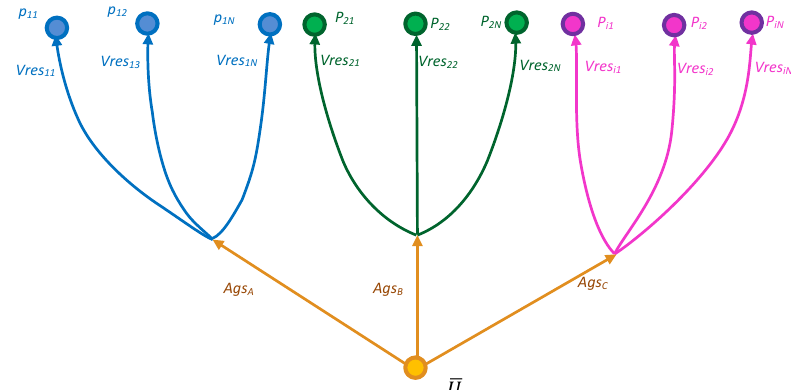
Fig. 1: Converted fragment of a fuzzy hierarchical situation-evidence-based university offices classification network 𝑈𝑈𝑈𝑈� based on the ABC-principle